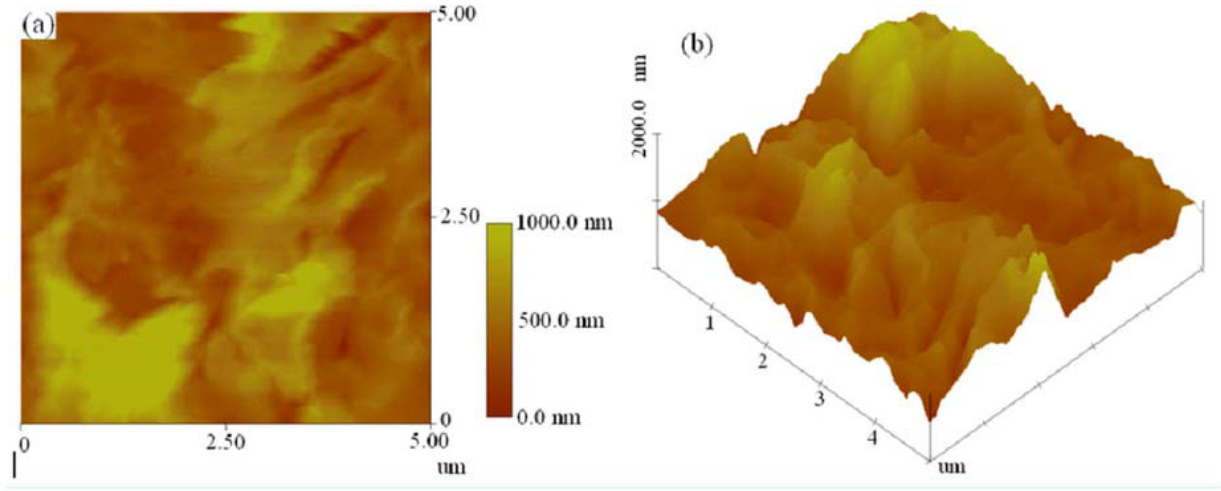
Figure 3. Atomic force microscopy images of a lead (6 mM)/glassy carbon film.